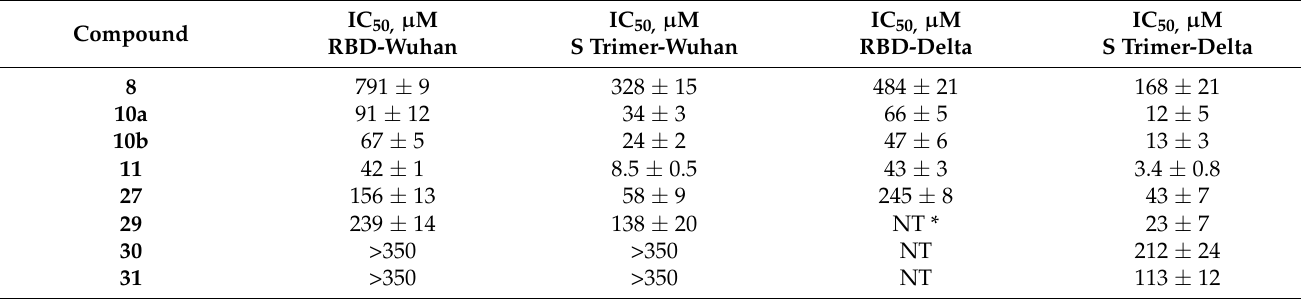
Table 5. Results of the inhibition of the SARS-CoV-2-S-RBD/S trimer binding to ACE2 compounds in the present